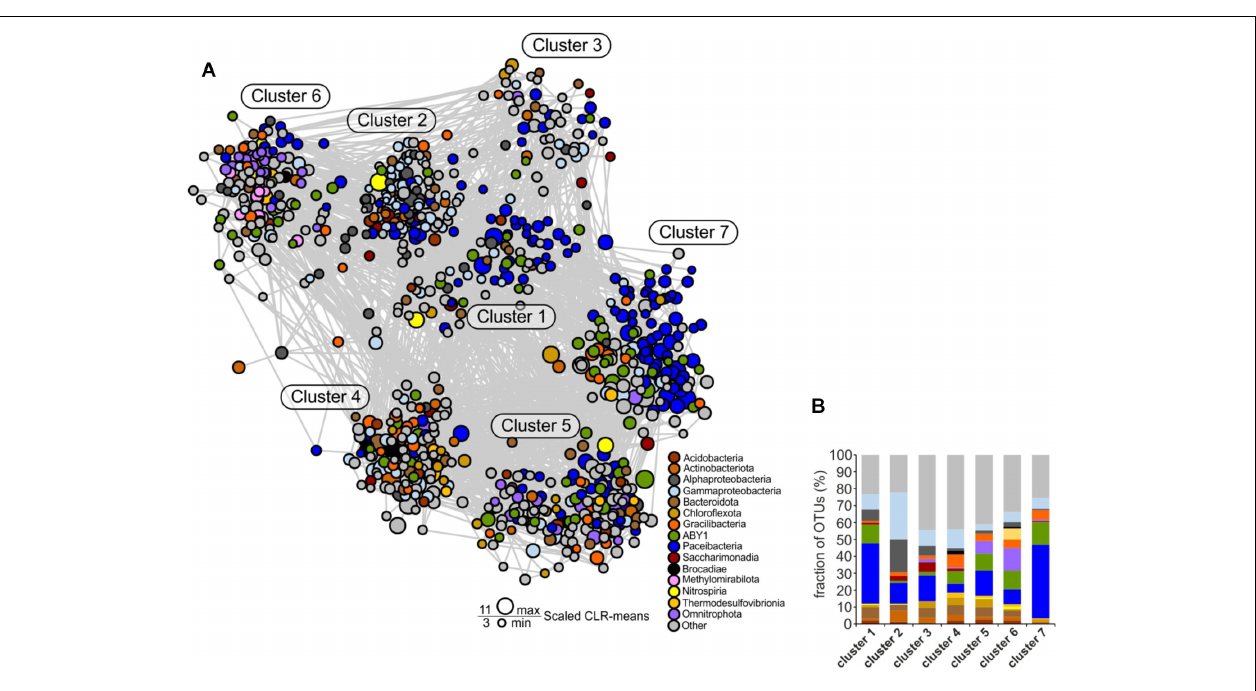
oxidizers in the groundwater co-occurred more frequently with OTUs affiliated with candidate class ABY1 or Cand